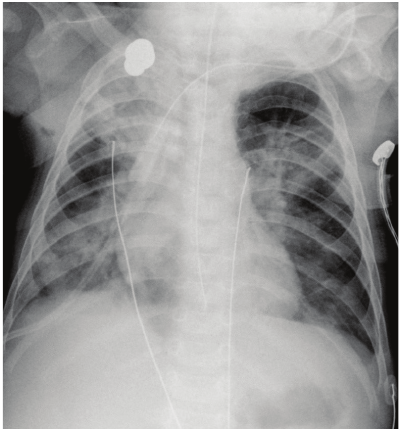
Figure 1: Thoracic X-ray on